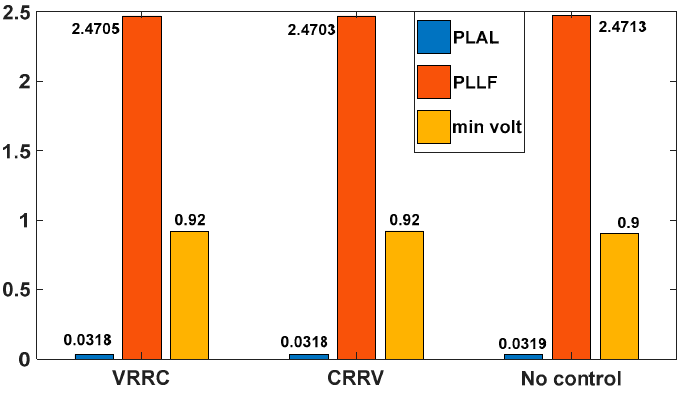
Figure 9. The evaluation factors of the three schemes.